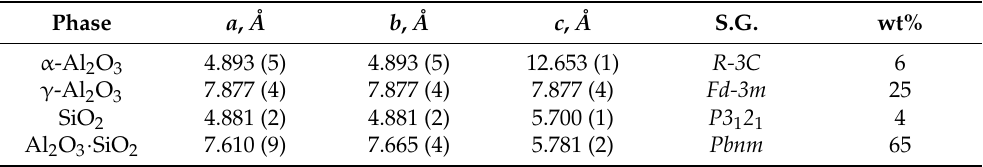
Figure 11. The observed (red dots at top), calculated (lines in the middle) and differential (blue line at the bottom) XRD patterns (in CuK α -radiation) of the PEO layer synthesized on the AK12 alloy in a slightly alkaline electrolyte of 3 g/L KOH + 2 g/L Na2SiO3 composition. The numbers indicate the reflections corresponding to (1) α -Al 2 O 3 , (2) γ -Al 2 O 3 , (3) SiO2 and (4) Al 2 O 3 · SiO2 phases. Table 3. Crystallographic parameters and quantitative content of phases in the PEO layer